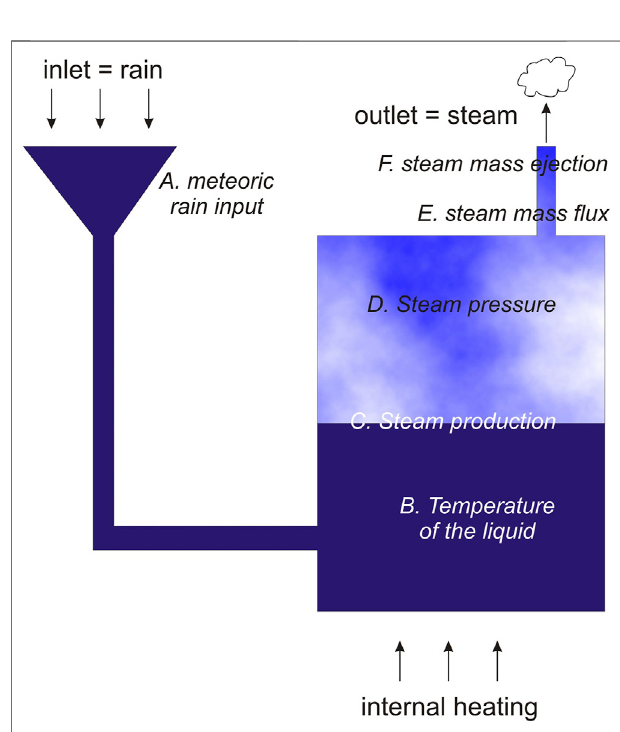
FIGURE7| Mainpartsoftheshallowhydrothermalsystemconnectedto the South Cratervents with indication ofthe main parameters ofthe numerical model whose results are shown in Figure 8